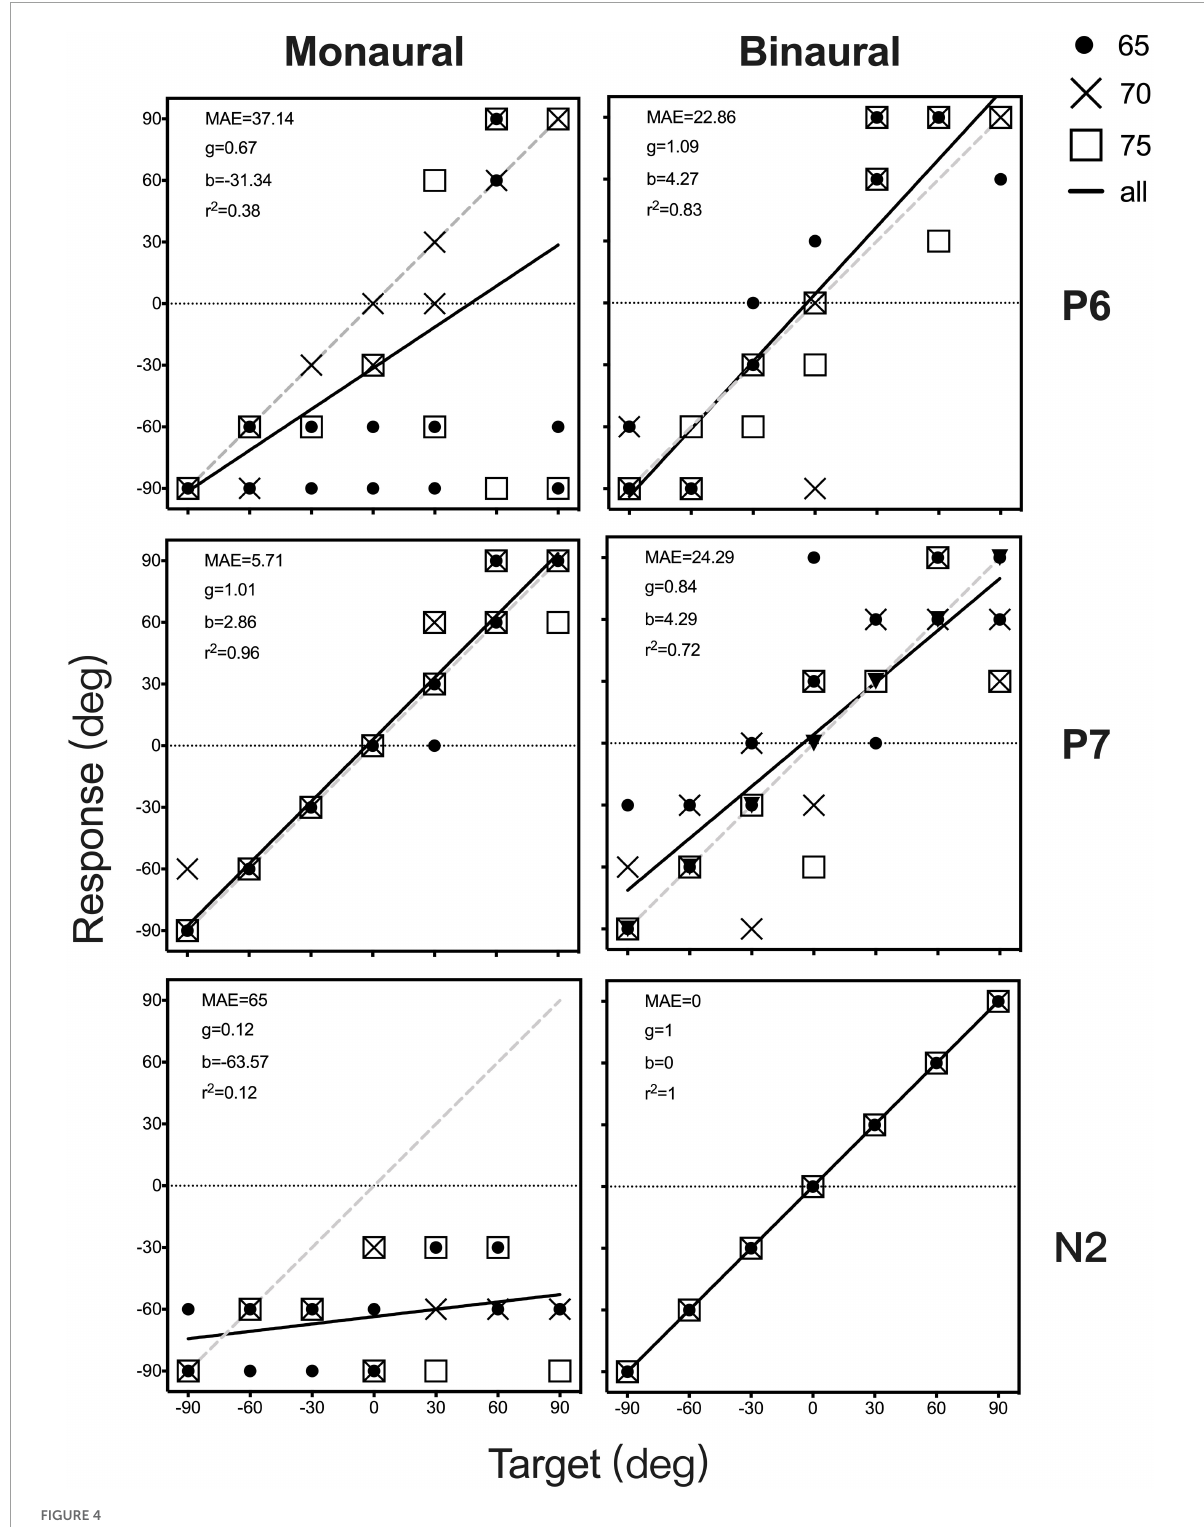
FIGURE4 Sound localization target-response plots of two patients (P6 and P7) and one control (N2) in monaural (unaided and P, left) and binaural (aided and UP, right) listening conditions. Stimulus sound levels are indicated by black circle (65 dB SPL), and cross data (70 dB SPL), and white square points (75 dB SPL). Best-fit linear regression is indicated by a black line. For participants with an ideal optimal localization ability, gain is 1, whereas MAE and b are 0. MAE, mean absolute error; g, response gain; b, response bias; r 2 , R